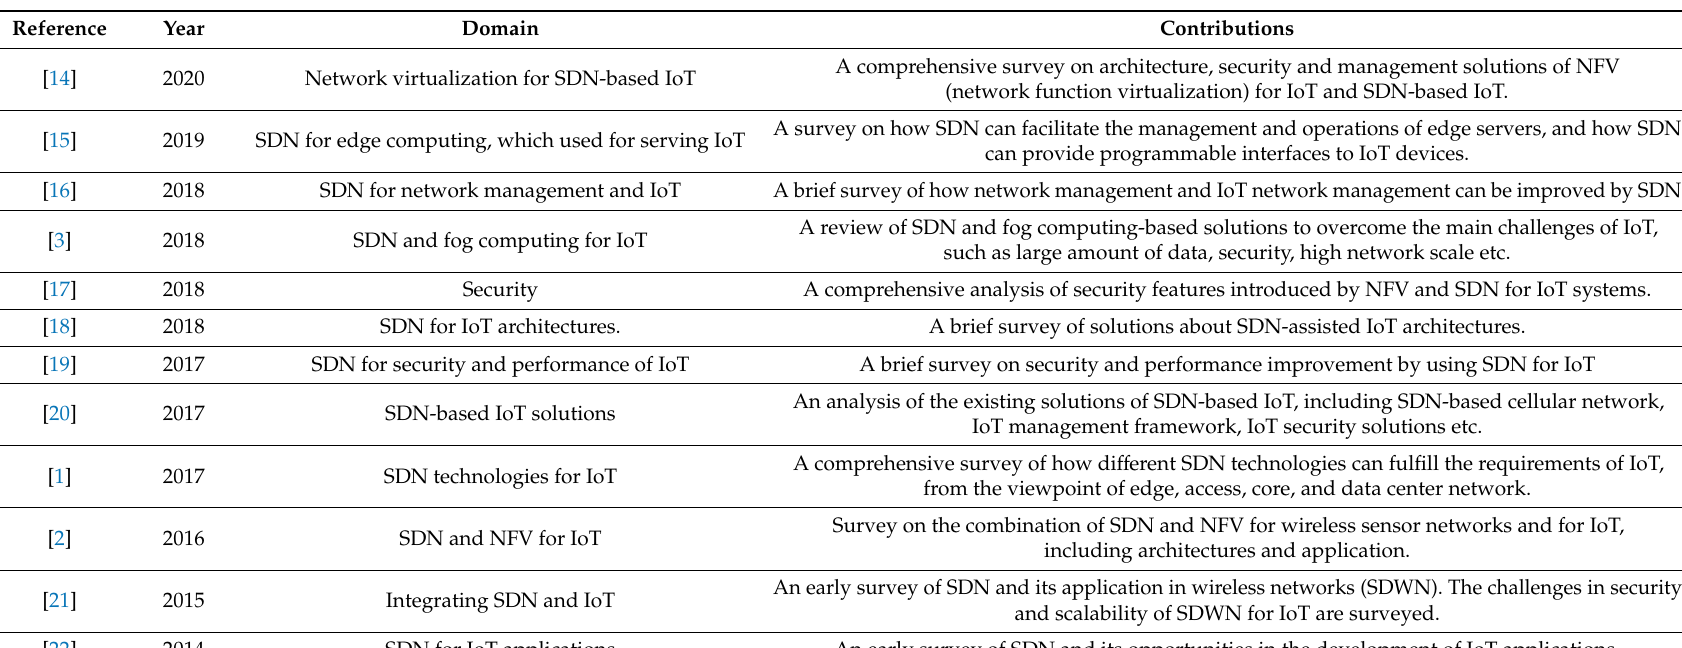
Table 1. Comparison of surveys about SDN and